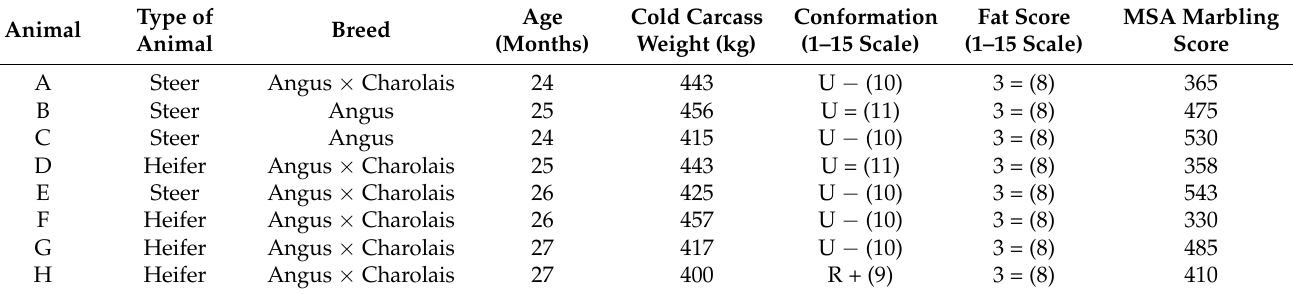
Table 1. Animals characteristics at